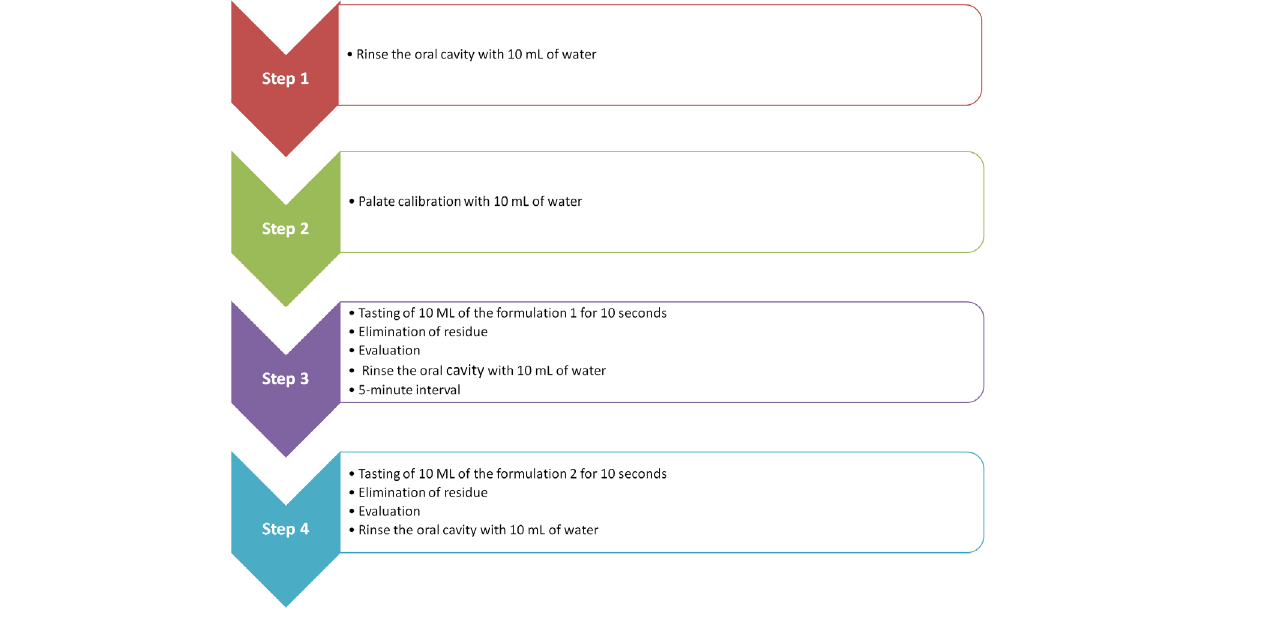
Figure 2 - Flowchart of human palatability test